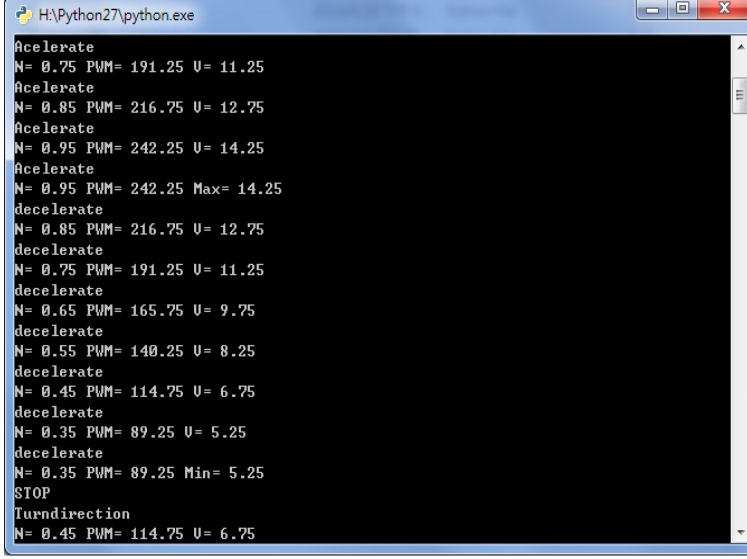
Figure 10. Manual power setting display windows.